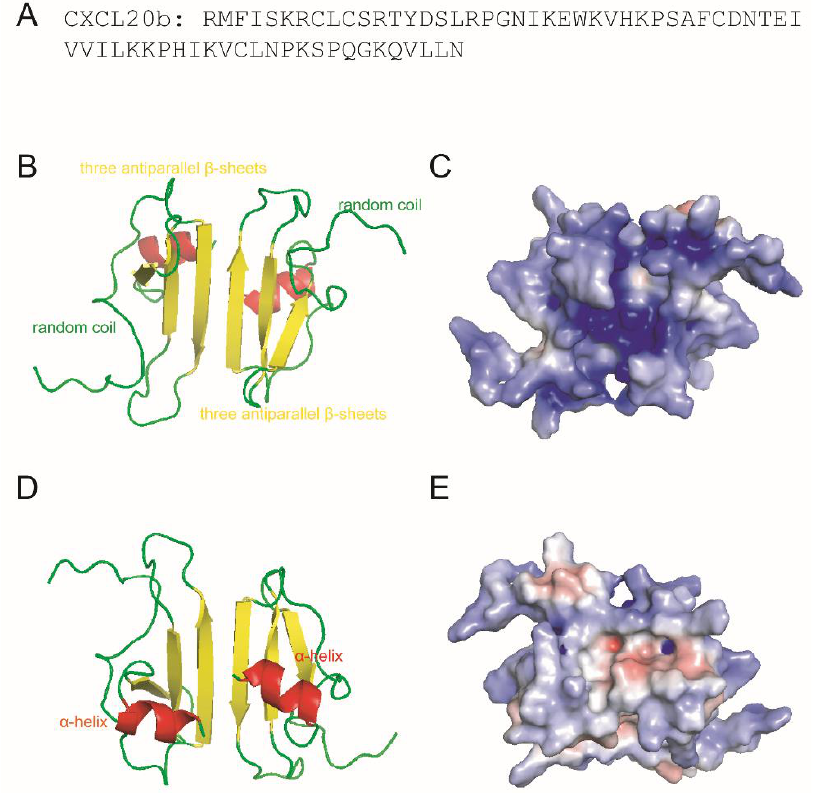
Figure 2. 3D modeling and surface charge distribution analysis of grass carp CXCL20b. ( A ) The amino acids sequence of CXCL20b. ( B , D ) On the basis of the prediction of grass carp CXCL20b, the images show a 3D model of CXCL20b dimers. Grass carp CXCL20b features a typical mammalian chemokine structure, including N-terminal random coil (green), core structure containing three antiparallel β -strands ( yellow ), and C-terminal α -helix ( red ). ( C , E ) Electrostatic potentials mapped onto the surfaces of grass carp CXCL20b. Blue represents the cationic regions, red represents the negative regions, and white represents the hydrophobic residues.